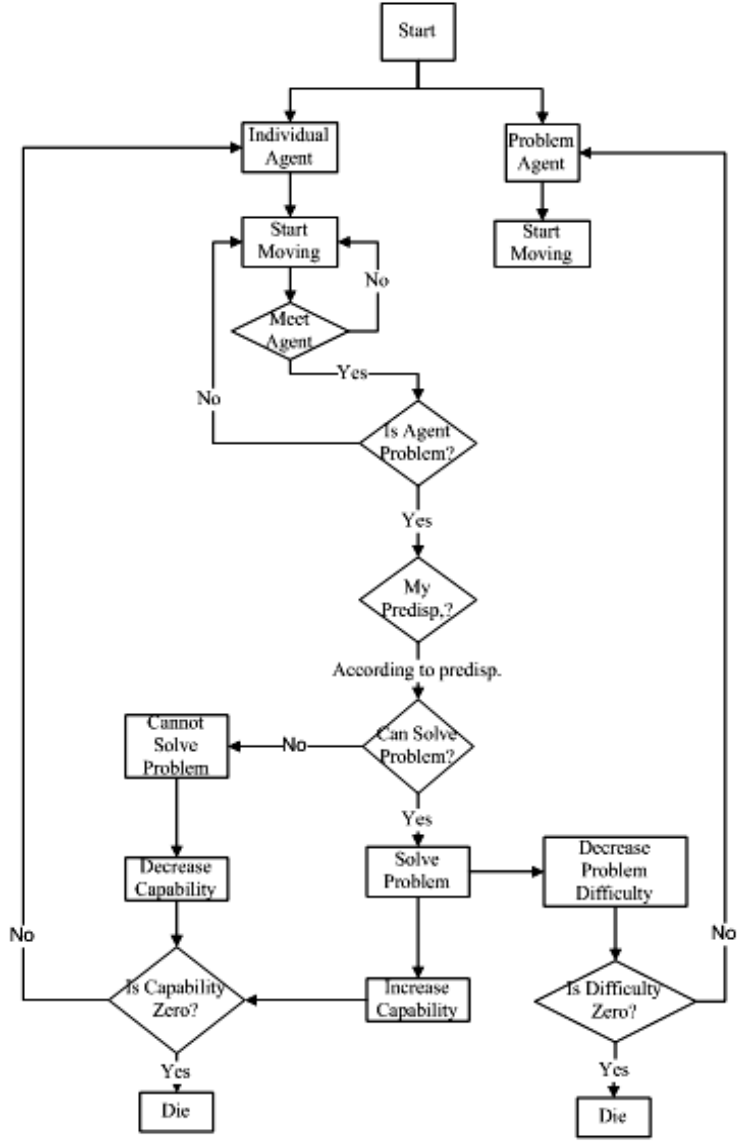
Figure 7. Common Rule Diagram for Interacting